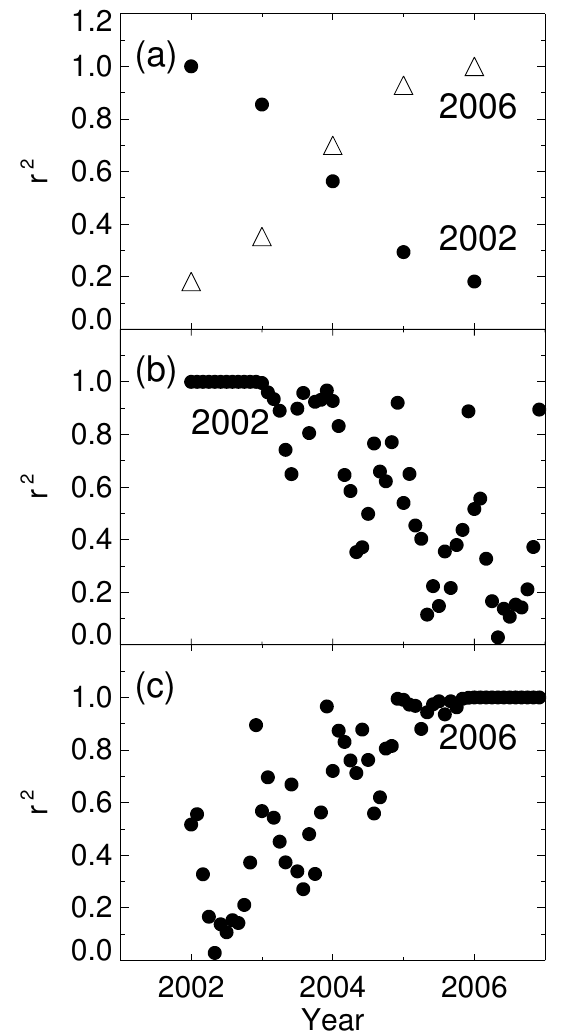
Fig. 4. Correlation analysis of the solar cycle dependence of the echo occurrence. Circles (triangles) in panel (a) show correlation co-efficients between the occurrence values in 2002 (2006) and all considered years from Fig. 3. Panels (b) and (c) are the same as, re- spectively, circles and triangles in panel (a) except that occurrences for each month were cross-correlated here between different